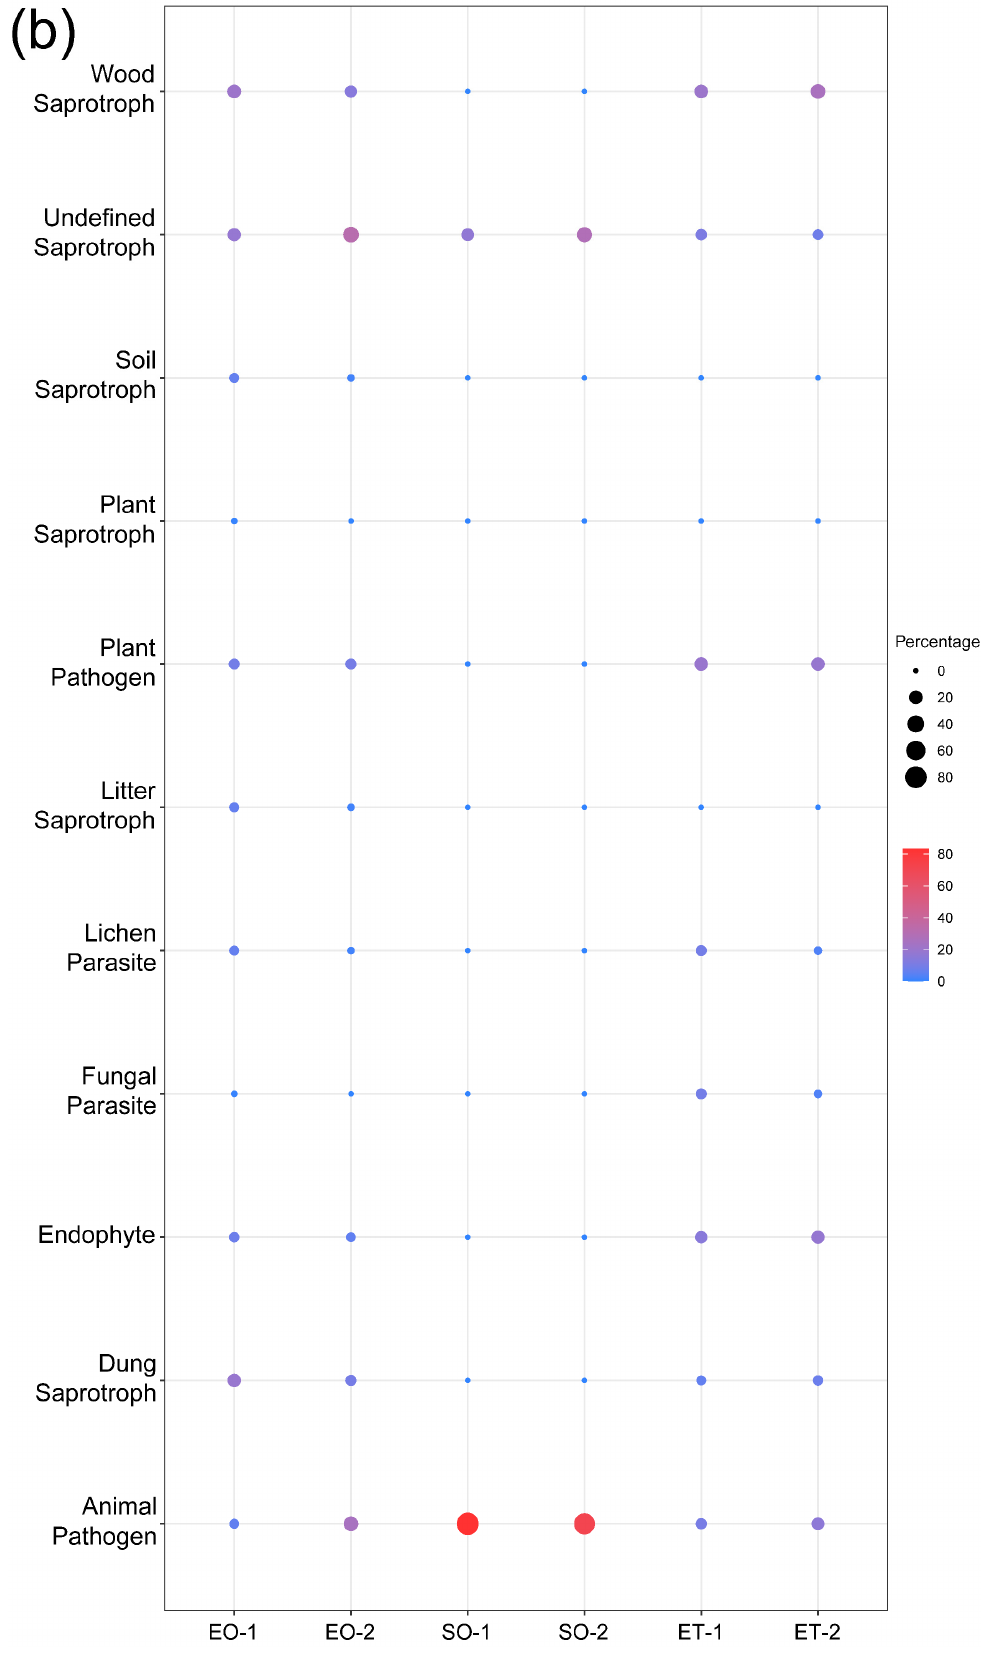
Figure 7. Prediction of the ecological functions for ( a ) bacteria and ( b )